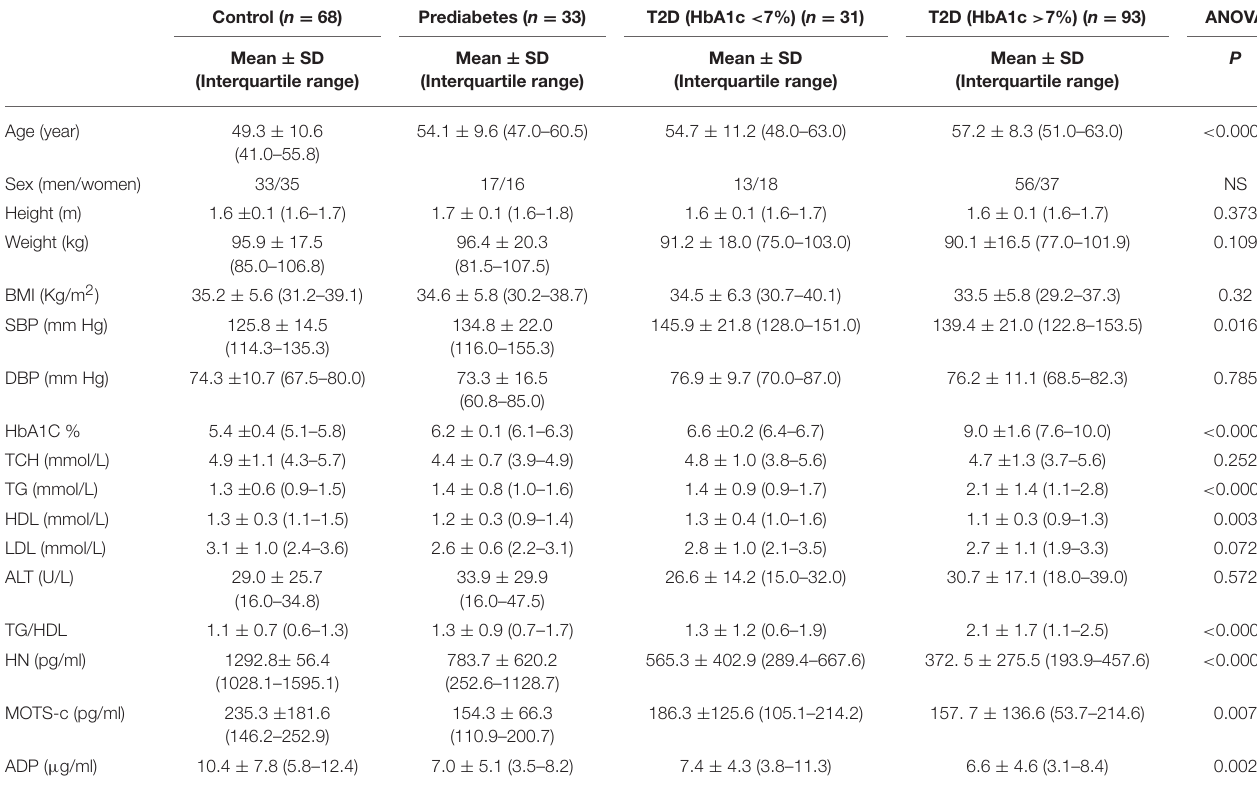
TABLE 1A | Clinical and metabolic features of study subjects. Control ( n = 68) Prediabetes ( n =